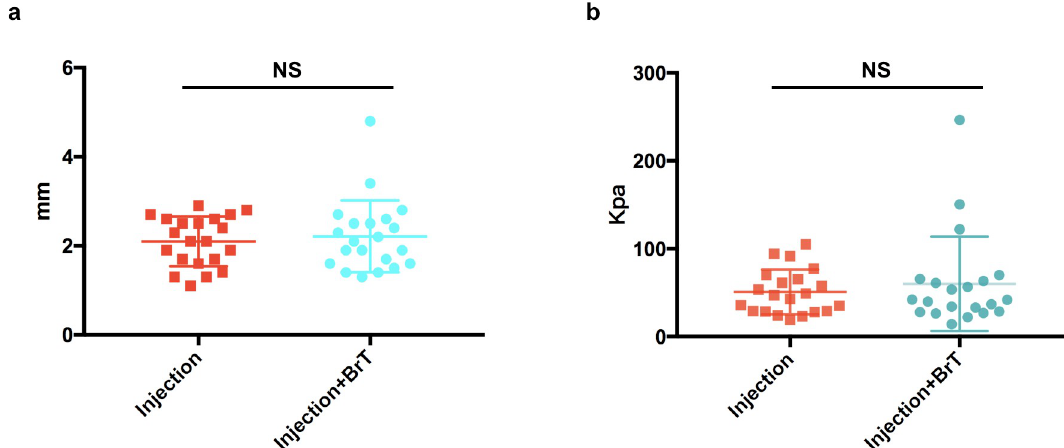
Fig 3. Baseline difference testing between the experimental group and the control group. There was no significant difference between two groups in terms of (a) lesions’ thickness or (b) ultrasonic elasticity. NS, p > 0.05.